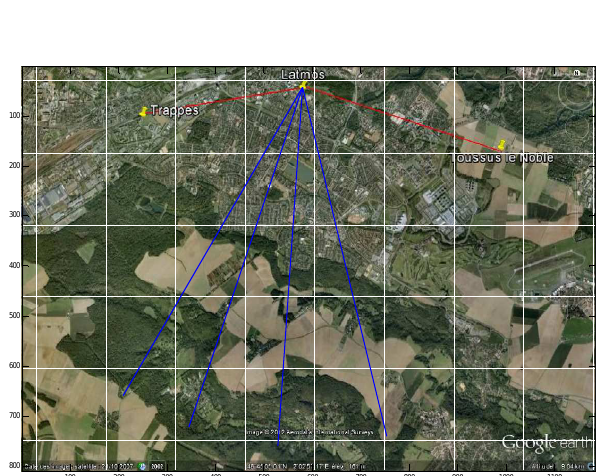
Fig. 4. Locations of the different sites and satellite path links